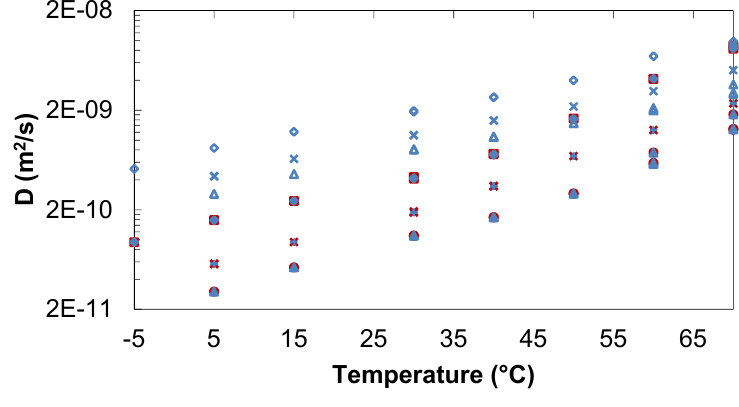
Figure 2. Diffusion of trehalose, lactose and water in trehalose/lactose/water solutions. Tre/Lac 34/34 mg/mL: ♦ Tre, ■ Lac, D Tre/Lac 254/254 mg/mL: ▲ Tre, ● Lac, D